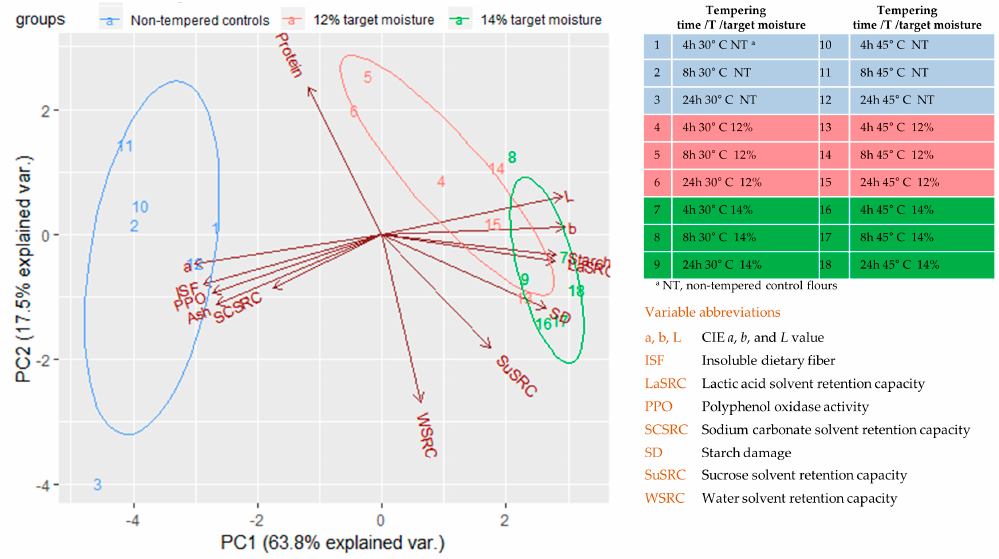
Figure 3. Principal component (PC) analysis of intermediate wheatgrass flours obtained via various tempering conditions.